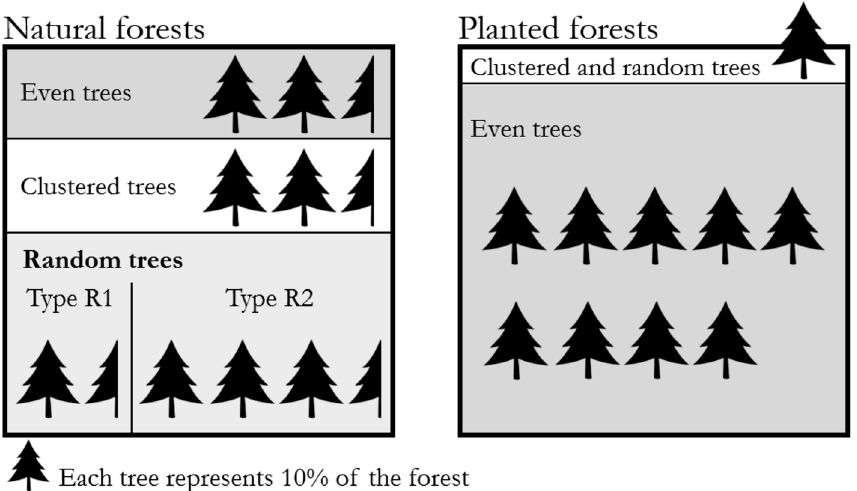
Figure 7. The proportion of structural types in natural and planted forests. The number of “trees” shows the approximate proportion of different